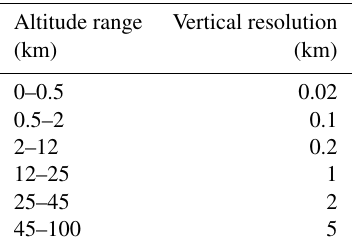
Table 2. Vertical resolution used for the radiative transfer simula-